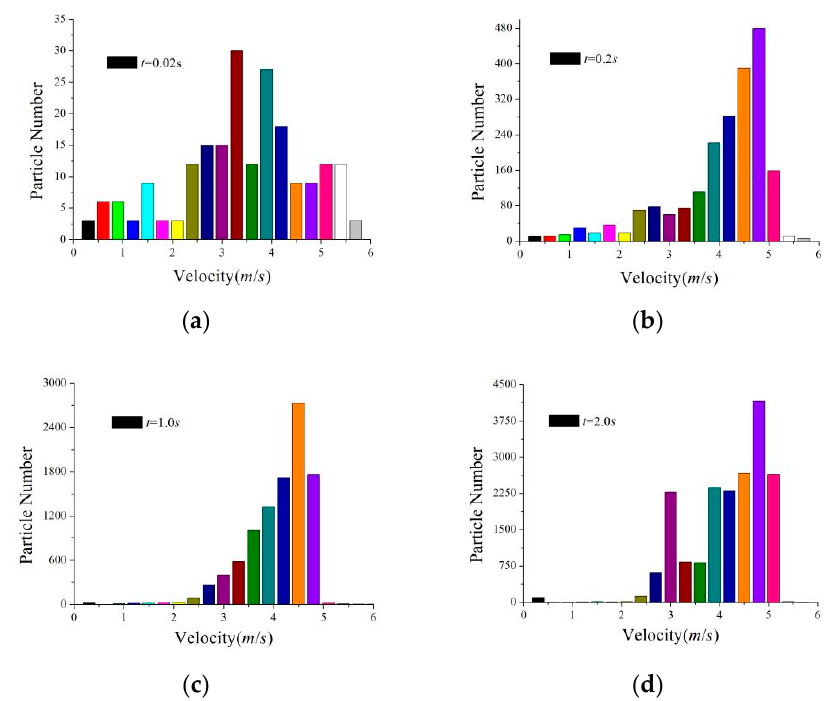
Figure 8. Velocity distribution of fine particles at different times in the flow field.